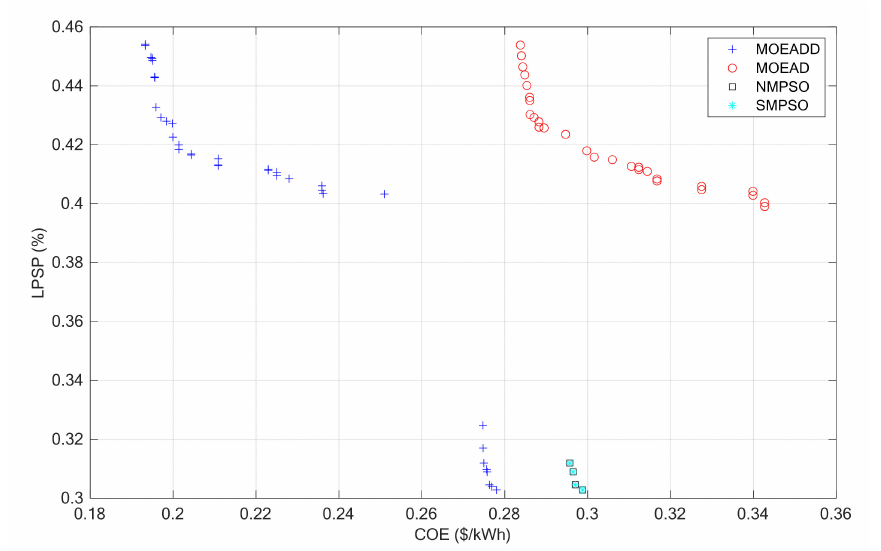
Figure 11. Comparison of PFs obtained for CASE 2 using different